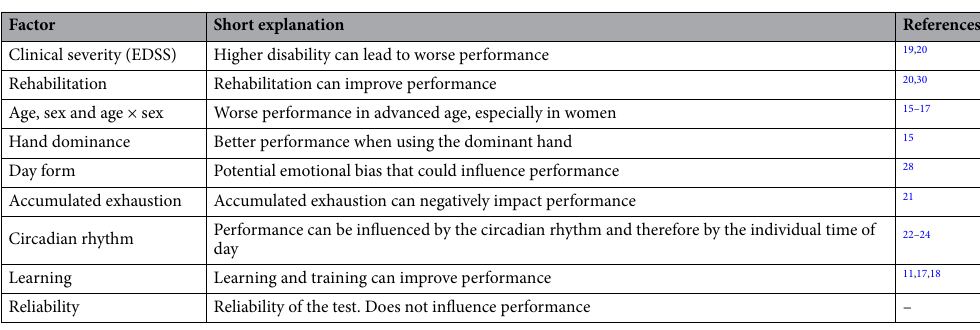
Table 1. Effects covered in the current